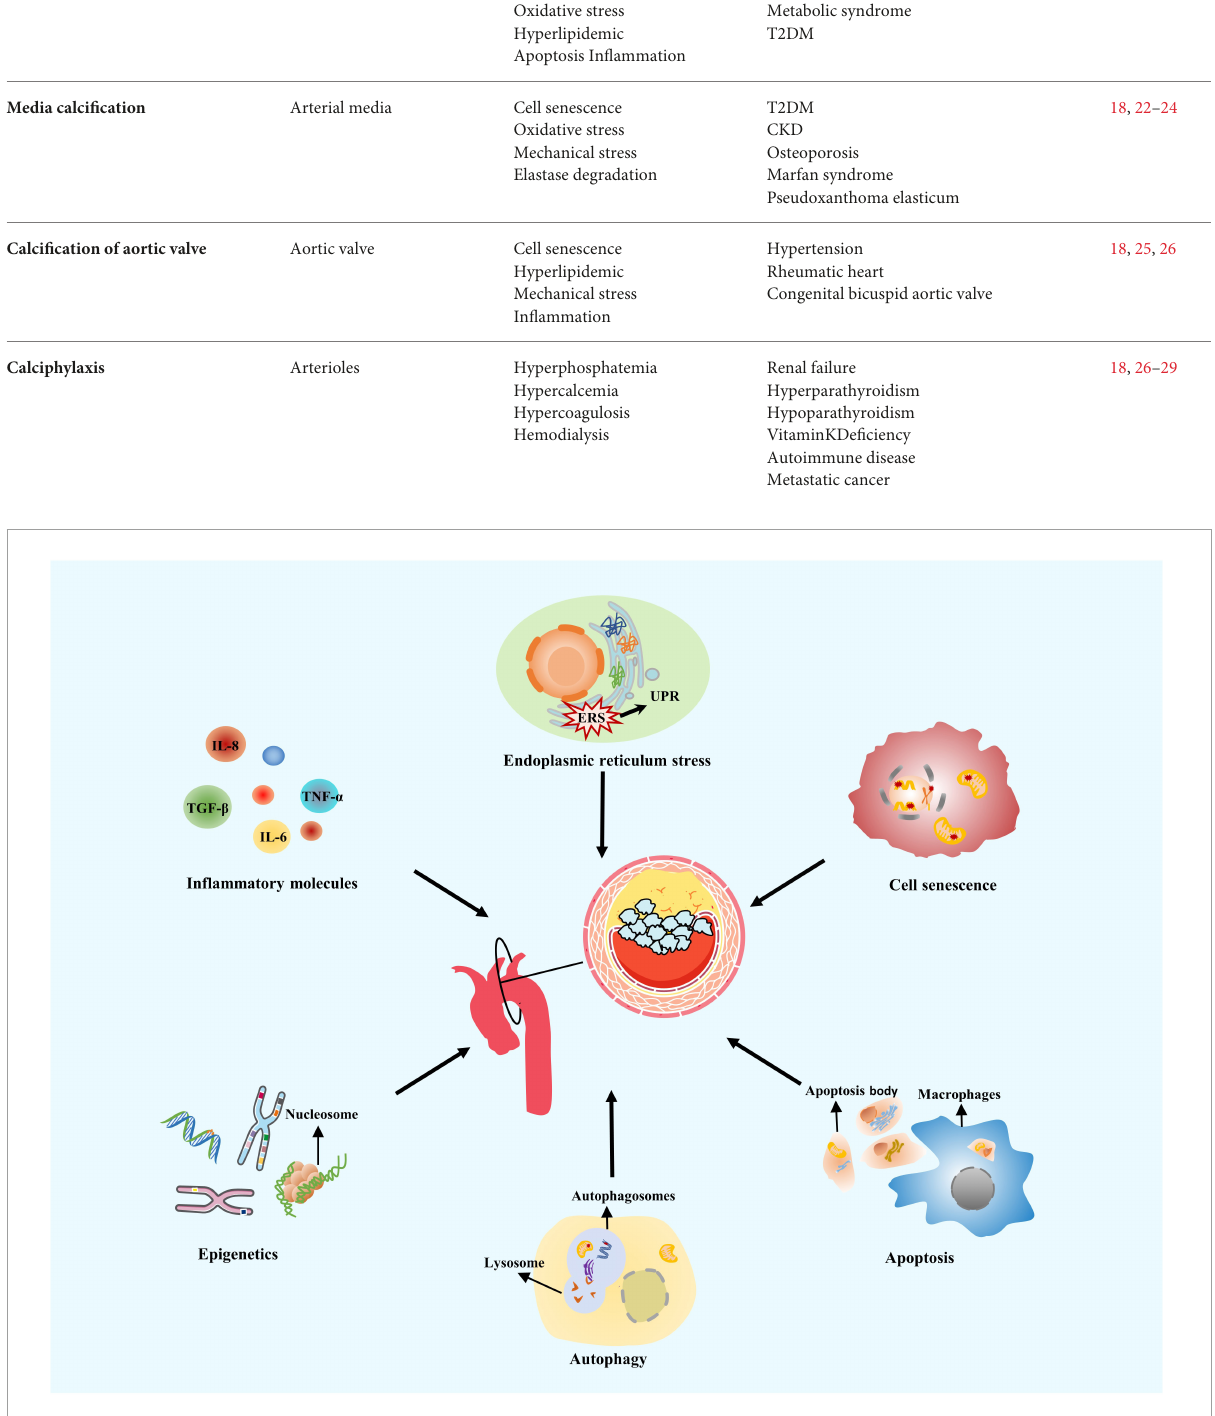
FIGURE1 Mechanisms of vascular calcification. Vascular calcification (VC) often occurs at the aortic arch under rapid blood flow to generate strong shear forces on arterial walls. Common VC mechanisms include chronic inflammation, endoplasmic reticulum stress, cell senescence, autophagy, apoptosis, and genetic